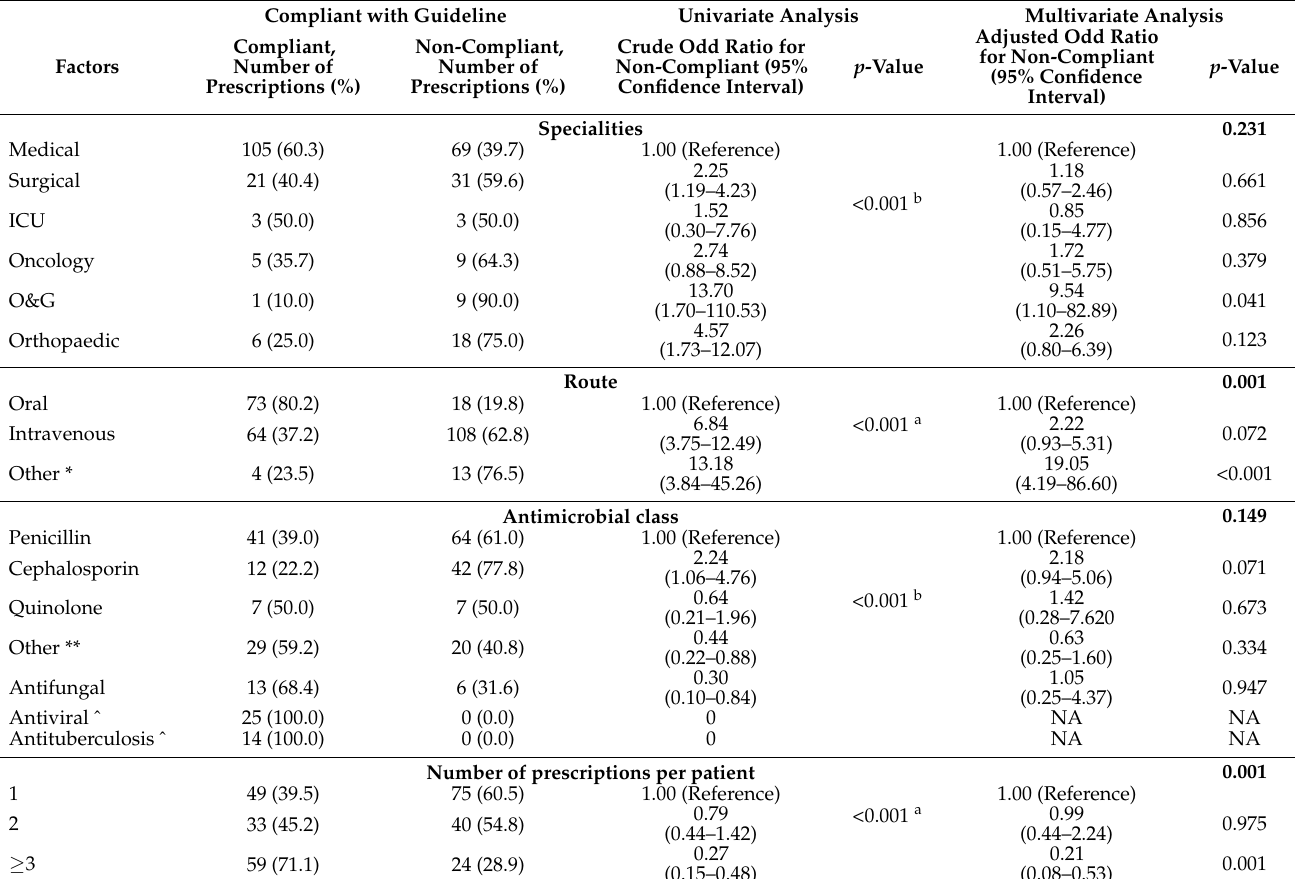
Table 3. Univariable and multivariable analysis of the associations between potential factors with guidelines noncompliance ( n =